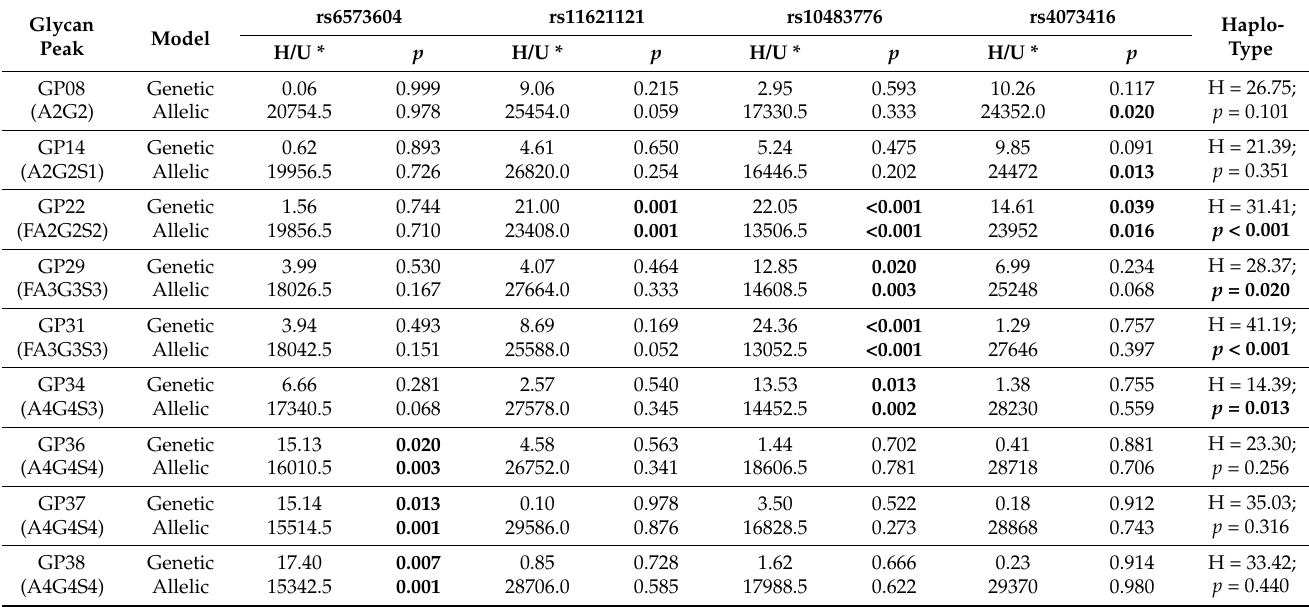
Table 4. Significant associations of the individual rs6573604, rs11621121, rs10483776, and rs4073416 polymorphisms (genetic and allelic model) as well as the rs11621121–rs10483776 haplotypes with the plasma N-glycan levels in the control participants.